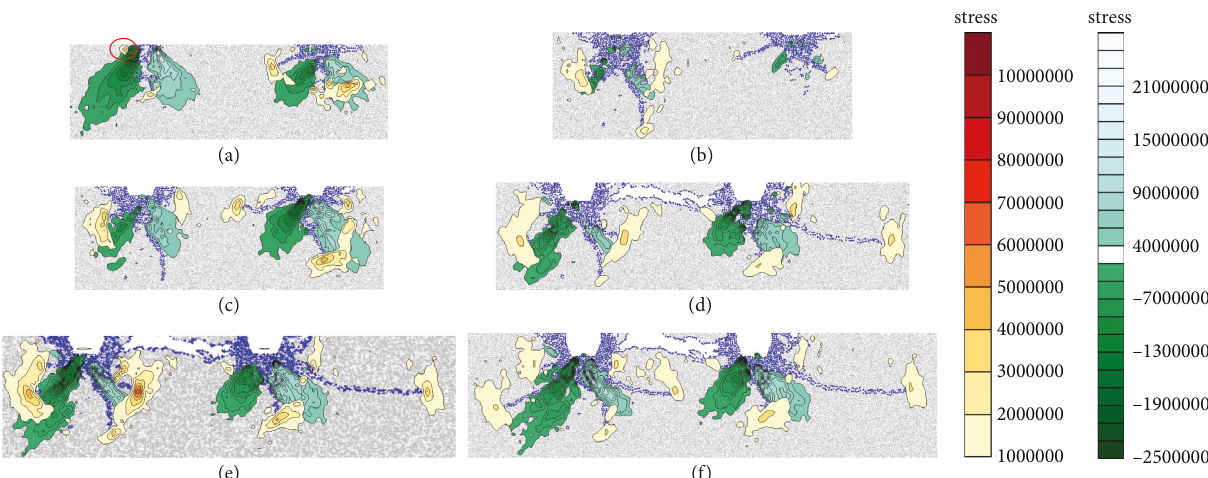
Figure 12: Stress distributions at peak and bottom points: (a), (b), (c), (d), (e), and (f) are the stress distributions at P1, B1, P2, B2, P3, and B3.